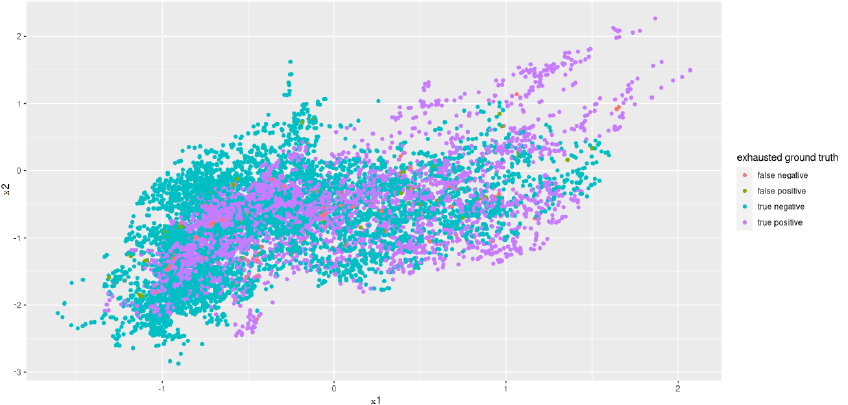
Figure 13. Principal components 1 and 2 for results of best classification model (DTC) after grid search.